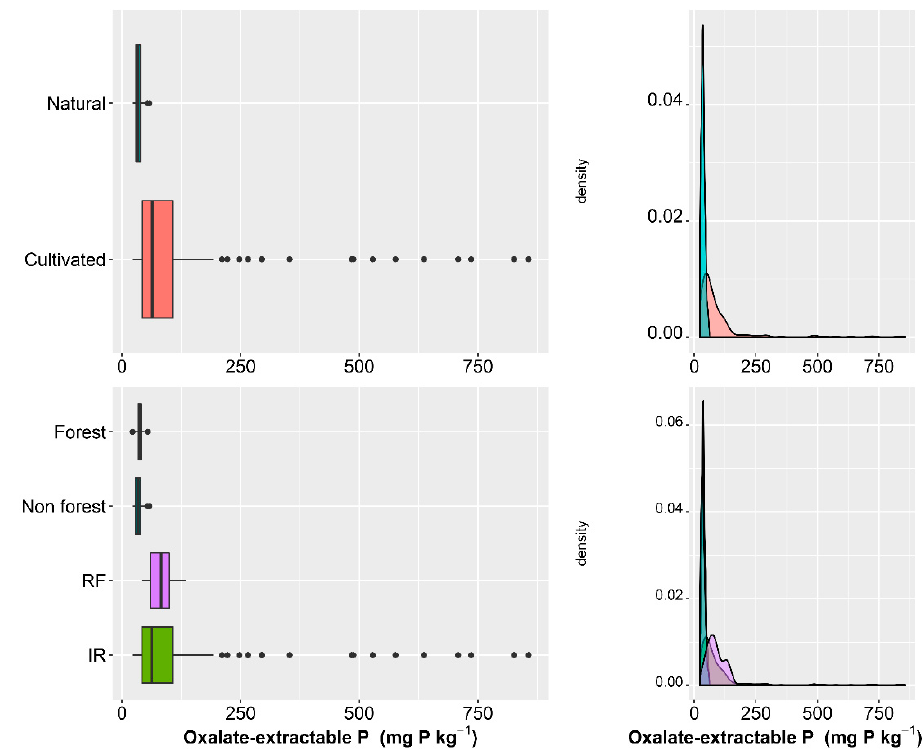
Figure 2. Distribution (left side) and kernel density plots (right side) for oxalate-extractable P content by the land-use system. RF: Upland rice field, IR: Lowland rice field. Table 4. Pearson correlation coe ffi cients between soil properties for each system.